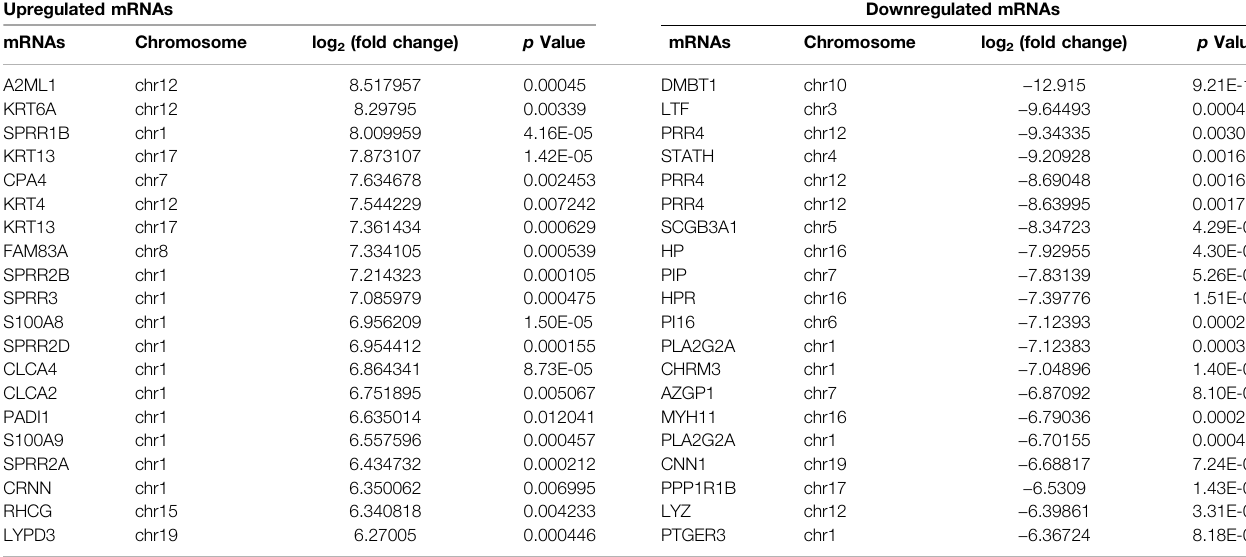
TABLE 3 | Top 20 differentially expressed mRNAs in SNIP tissues detected by microarray assay. Upregulated